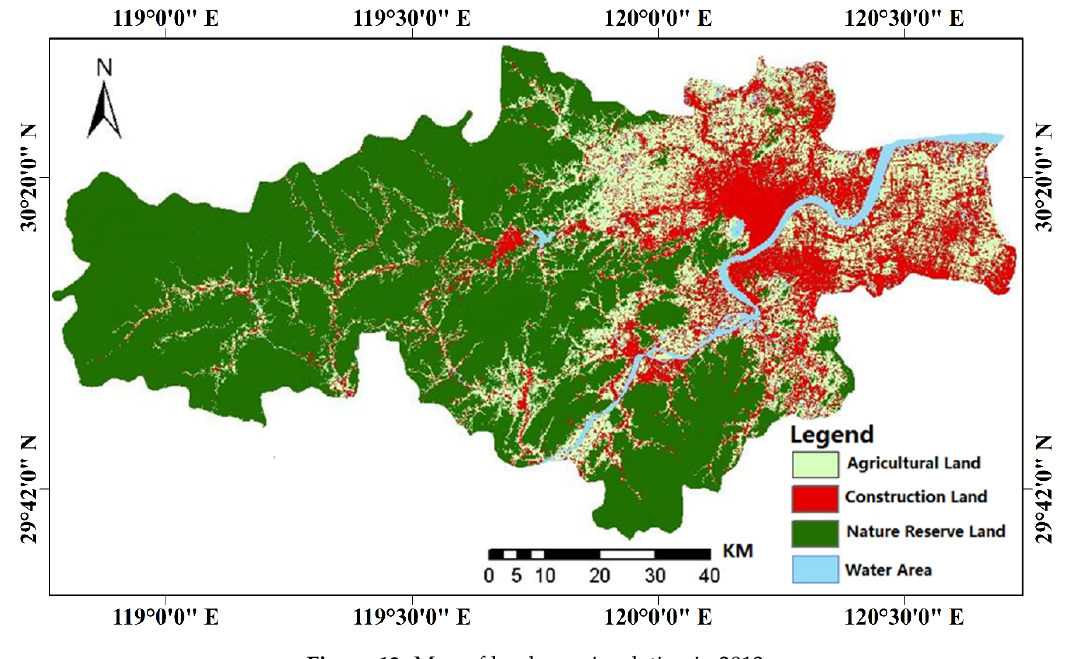
Figure 12. Map of land-use simulation in 2013. ISPRS Int. J. Geo-Inf. 2018 , 7 , x FOR PEER REVIEW